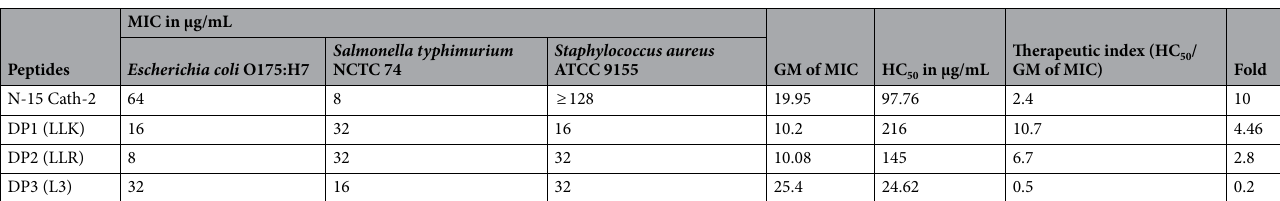
Table 2. MIC and HC50 activities of peptides against bacterial strains and murine red blood cells (RBCs).